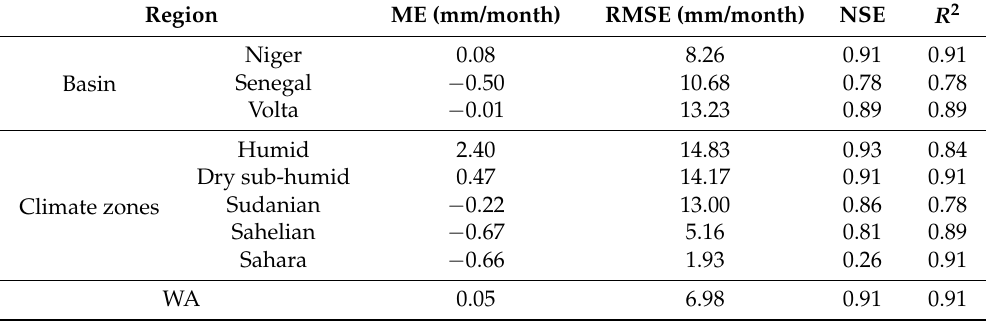
Table 4. Area-averaged statistics for backcasted GRACE-derived TWSC over river basins and sub-climatic zones (see Figure 1 for the Table 4. Area ‐ averaged statistics for backcasted GRACE ‐ derived TWSC over river basins and sub ‐ climatic zones (see Figure 1 for the regions). Region ME (mm/month)